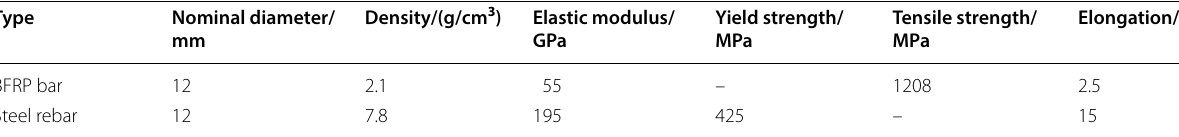
Table 1 Measured mechanical properties.